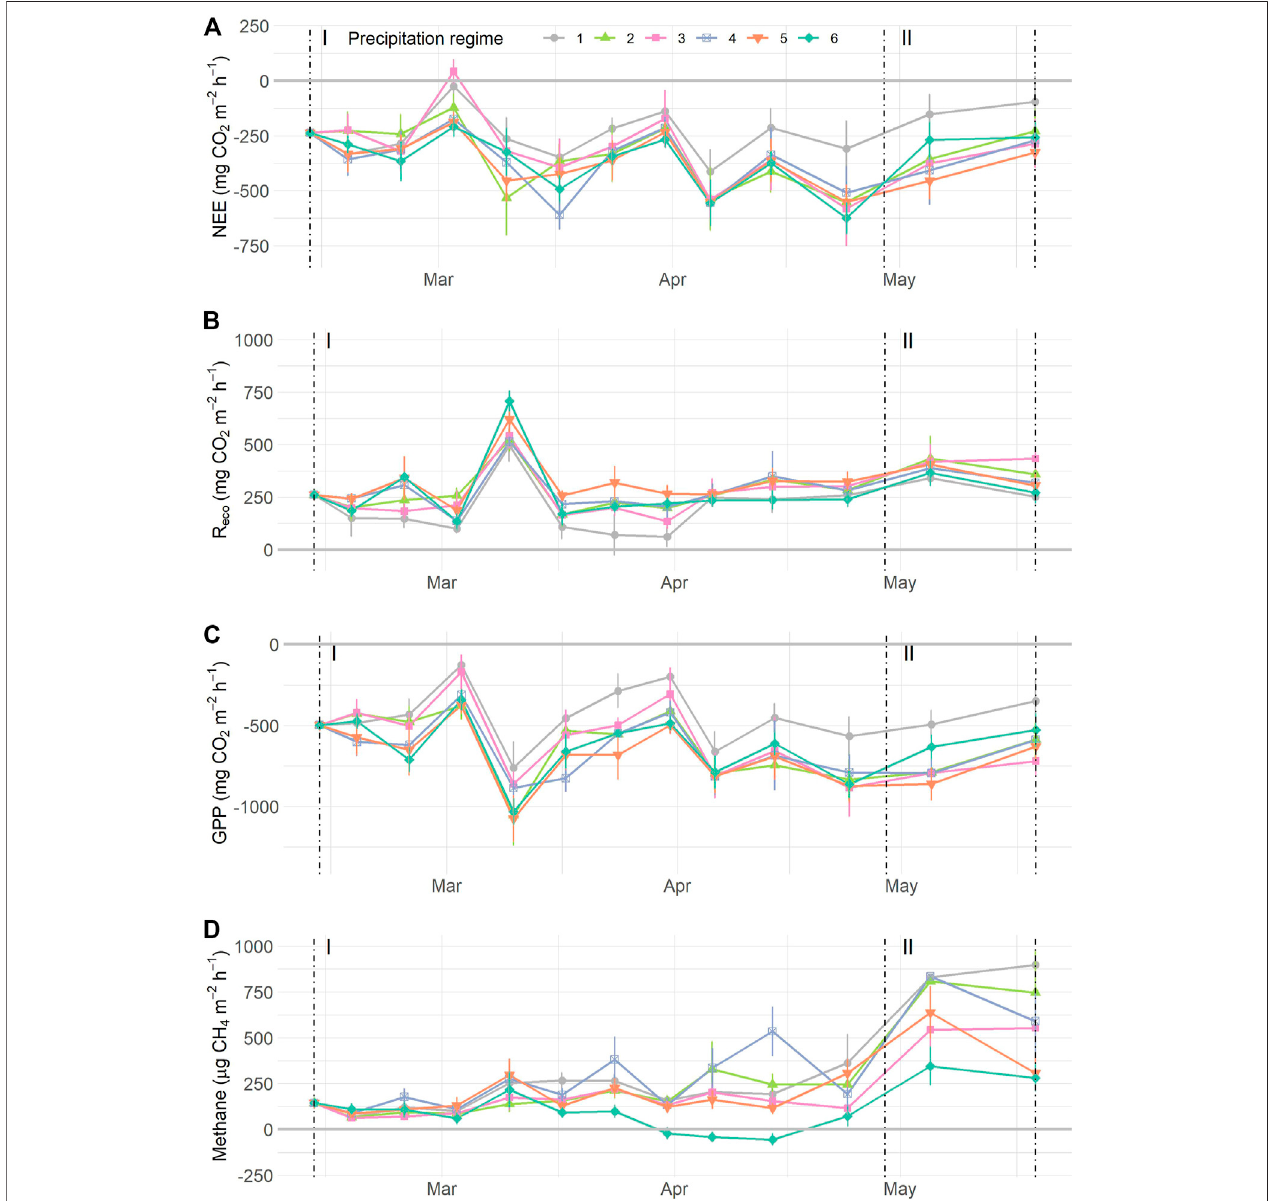
FIGURE 5 | Normalized carbon fl ux dynamics during the resistance phase (I) and resilience phase (II): (A) net ecosystem exchange (NEE) of CO 2 , (B) ecosystem respiration (R eco ), (C) gross primary production (GPP), and (D) methane (CH 4 ), grouped by precipitation regimes as indicated by symbols and colours. Values are means ± SE. In panels (A – C) , n (cid:2) 420; in (D) n (cid:2) 780. For details on precipitation regimes, please see Figure 1 . NOTE: data depicted have been normalized, see Supplementary Figure S9 for uncorrected